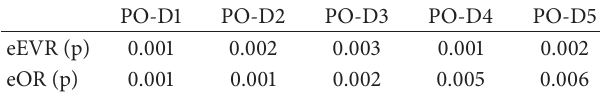
Table 2: Within-group comparison of LOOH.